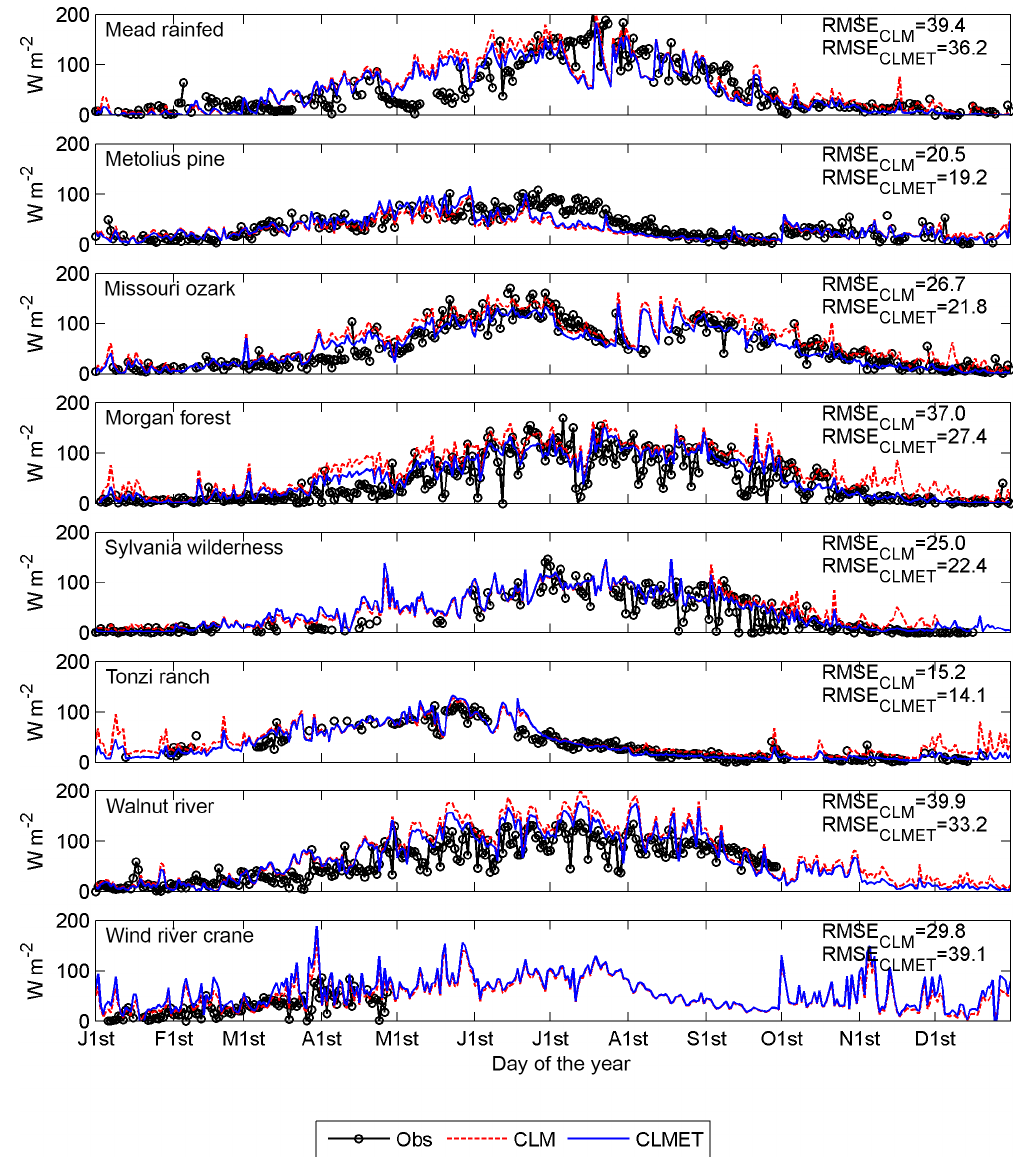
Figure 10. Daily mean latent heat fluxes from the CLM and CLMET grids and station observations at Mead Rainfed, Metolius Pine, Missouri Ozark, Morgan Forest, Sylvania Wilderness, Tonzi Ranch, Walnut River, and Wind River Crane. RMSE CLM and RMSE CLMET represent the root mean square error against observations for the CLM and CLMET,